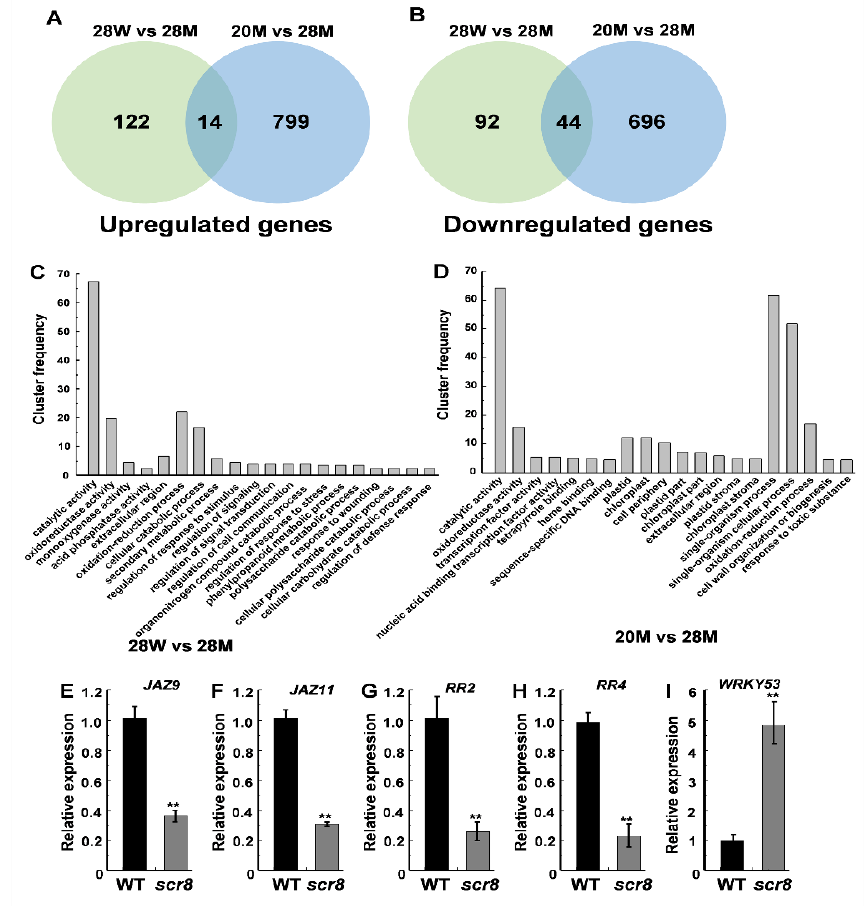
Figure 7. Transcriptome analysis of the WT and scr8 under different temperature treatment. ( A , B ) Venn diagrams showing transcriptome changes in 7-day-old WT and scr8 grown at 20 °C and 28 °C. The number of upregulated genes in scr8 ( A ). The number of downregulated genes in scr8 ( B ). ( C ) Top 20 significantly enriched GO terms compared between WT and scr8 when grown under high temperature. ( D ) Top 20 significantly enriched GO terms in scr8 after low temperature treatment. ( E – I ) Relative expression of JAZ9, JAZ11, RR2, RR4 , and WRKY53 genes in 7-day-old WT and scr8 . Error bars represent SD. ** Significant difference at p < 0.01 compared with the WT by Student’s t -test.